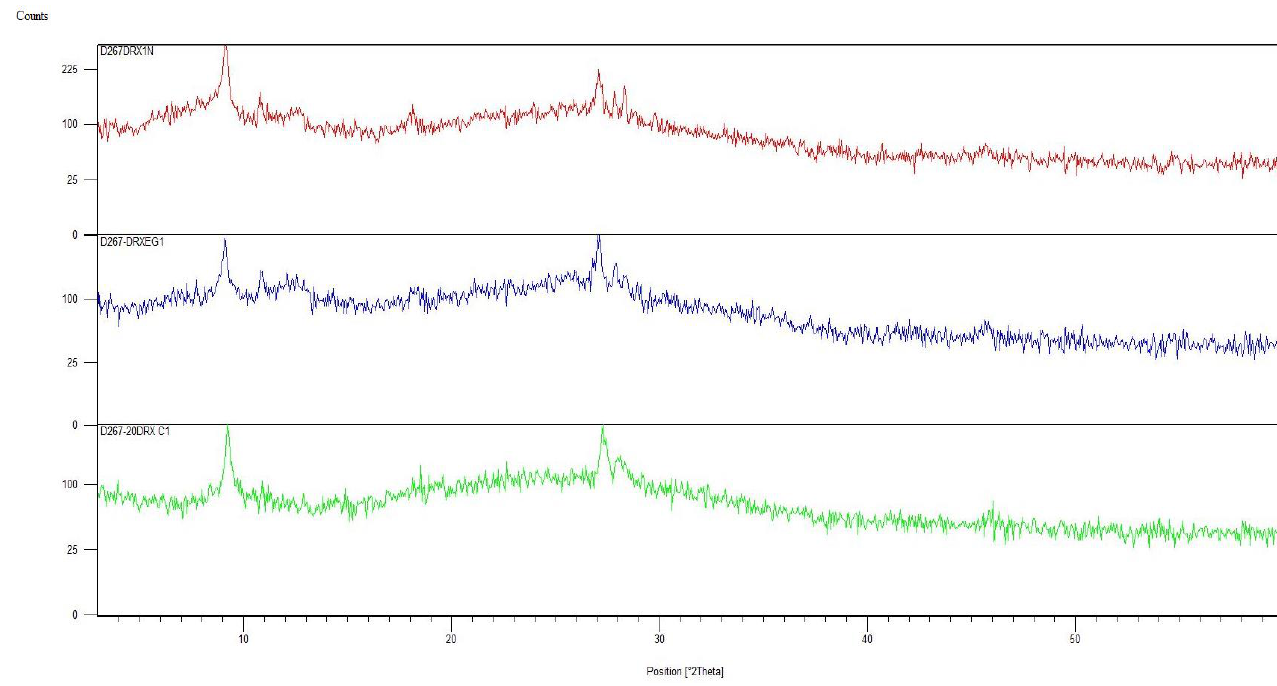
Figure B1. Diffractogram of X-rays on powder of the T1 sample.